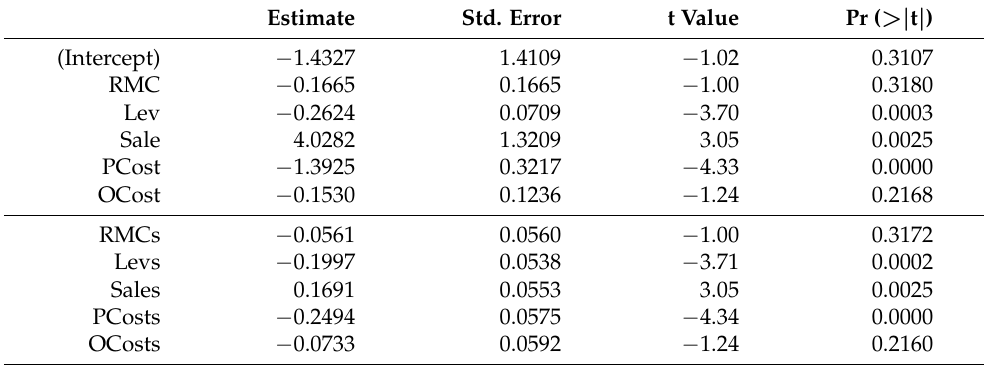
Table 1. OLS estimation of a risk management model for ROA. Denoting standardized regressors with the ‘s’ suffix and forcing a zero intercept, lower panel ‘estimates’ suggest practical significance in a linear model.